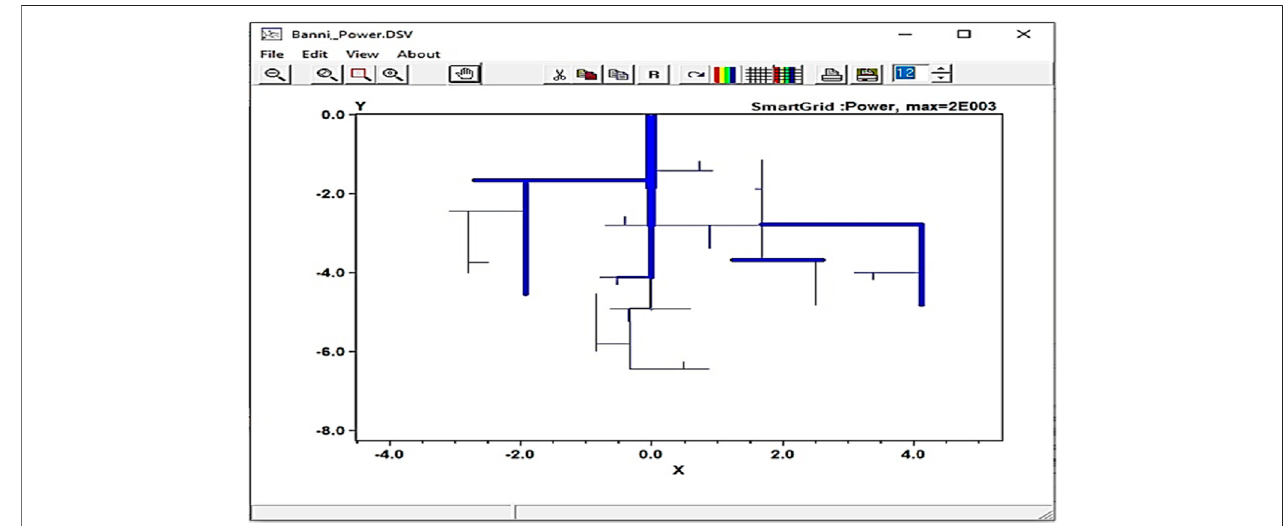
FIGURE 3 | Smart grid lines.